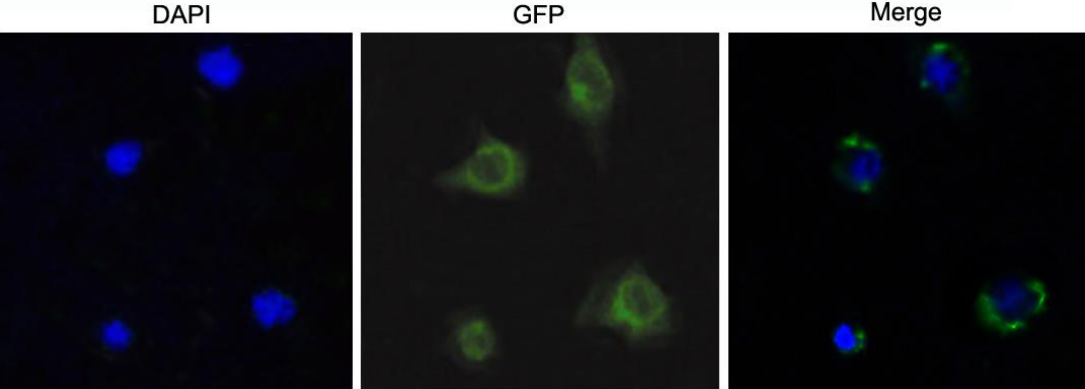
Figure 4. Subcellular localization of Mc IL17-1 in HEK293T cells. The recombinant pEGFP-N1- Mc IL17-1 plasmid was transfected into HEK293T cell using lipofectamine 3000, the green fluorescence showed the location of proteins and the cell nucleus location was indicated by blue DAPI staining. The Mc IL17-1 was mainly localized in the cytoplasm of HEK293T cells.